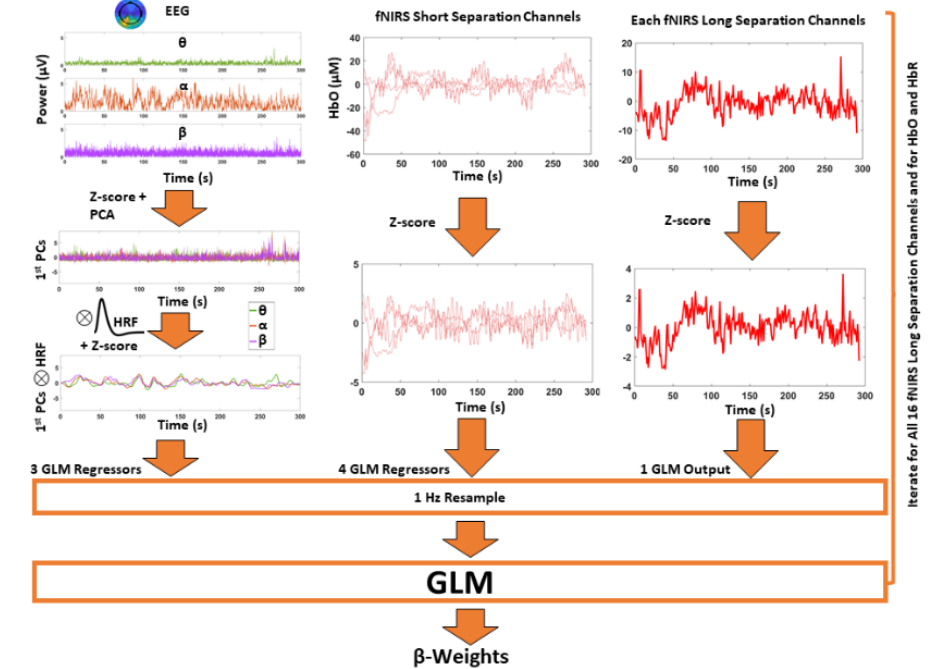
Figure 3. Algorithm for neurovascular coupling (NC) estimation from EEG-fNIRS recordings using a general linear model (GLM) framework. The independent variables of the GLM were the expected hemodynamic responses (z-scored, 1 Hz resampled) obtained from the convolution of the global EEG power envelopes with the canonical hemodynamic response function (HRF). The global EEG power envelopes were obtained by selecting the 1st principal components (PCs) of bandwise principal component analyses (PCAs). Control for scalp contamination was obtained by considering hemoglobin oscillations in the short separation fNIRS channels as additional independent variables (z-scored, 1 Hz resampled). The dependent variable was either HbO or HbR signal in each long separation fNIRS channel (z-scored, 1 Hz resampled). The analysis provided standardized β -weights depicting the strength of association (NC) between bandwise global EEG power envelopes and HbO and HbR in each long separation channel